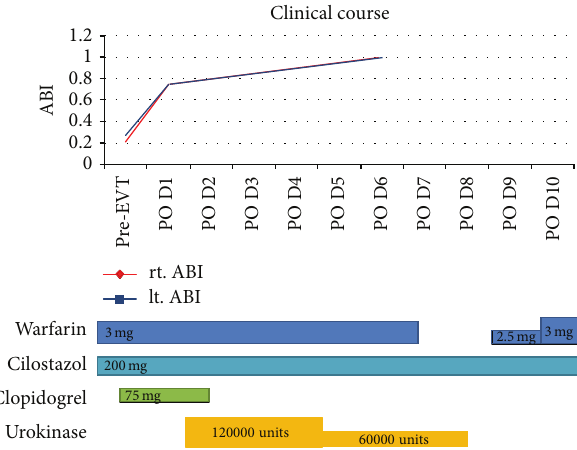
Figure 6: Clinical course after endovascular therapy. ABI: ankle- brachial index, EVT: endovascular therapy, and POD: postoperative